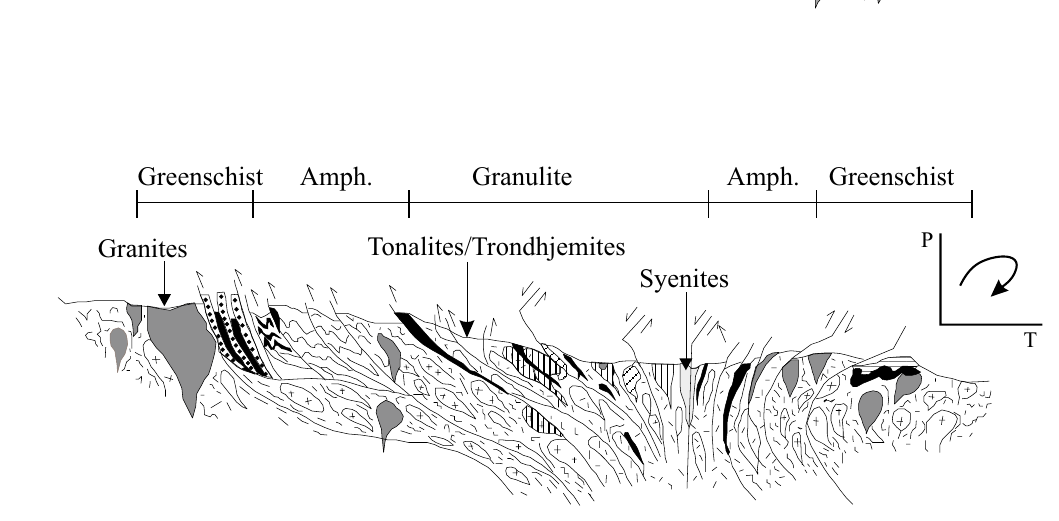
Fig. 6 – E-W sections in NE São Francisco Craton, which show only the Paleoproterozoic age rocks (see text for details). (a) intermediate Transamazonian collision stage with formation of Itapicuru and Capim Greenstone Belts and the basement thrusting over the Jacobina Group. The Caraíba and Medrado mafic-ultramafic intrusions and the syn-tectonic granites are related to this stage. (b)At the ultimate stage of the mountain building, syenite and post-tectonic granites have been intruded. Presently, in the western and eastern parts the superposition of granulitic terrains over the amphibolite and greenschist terrains can be seen. On the right-hand side of each cartoon, PTt diagrams are shown. The clockwise sense for the metamorphic path attests to the collisional context. GB = Greenstone